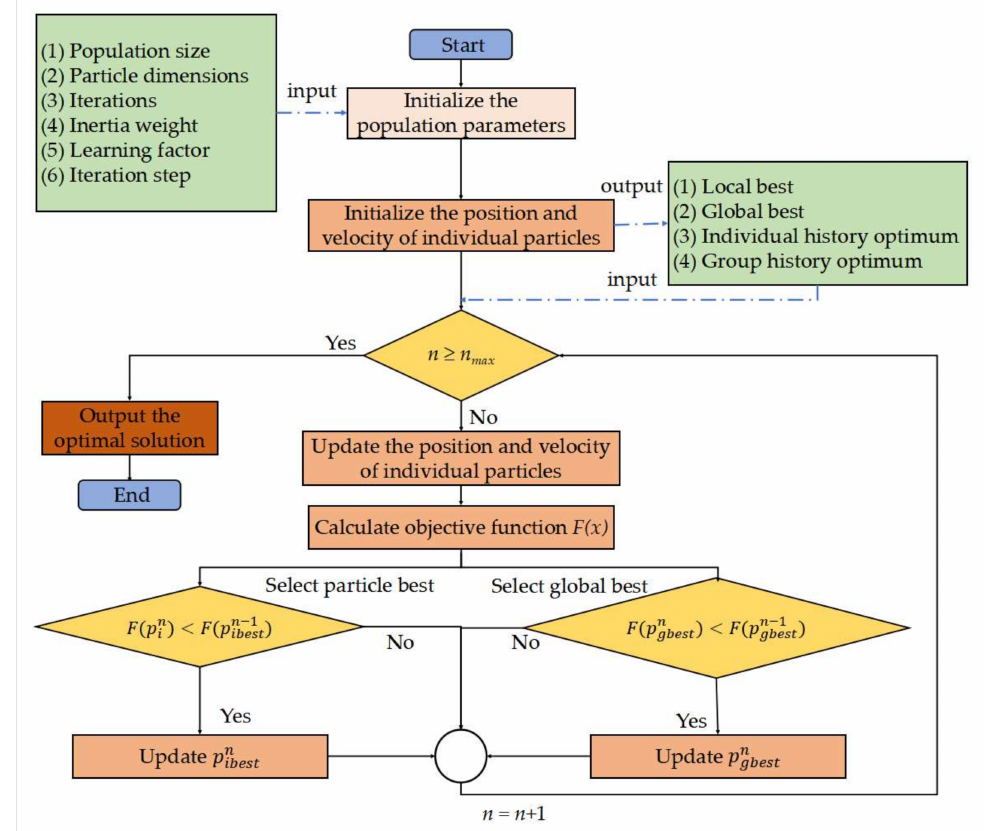
Figure 7. Workflow of the CPSO